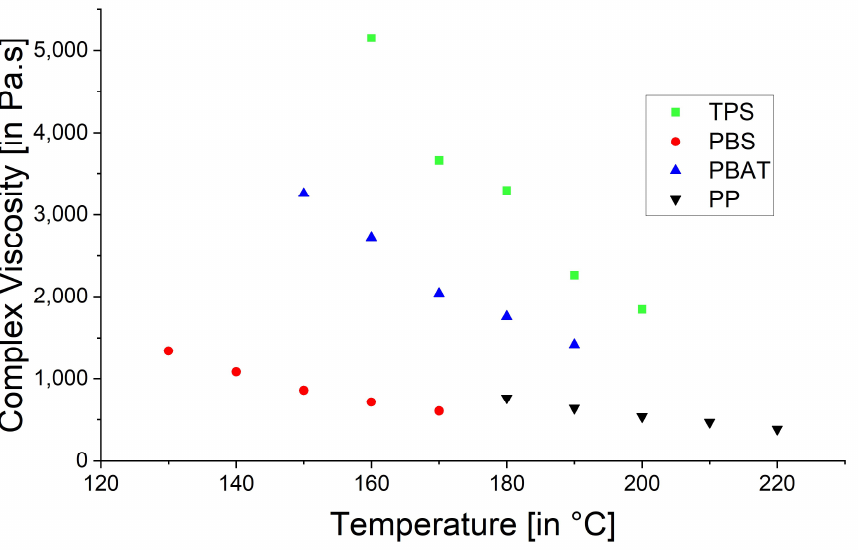
Figure 11. Complex viscosity as a function of temperature at 10 rad/s for four polymers.